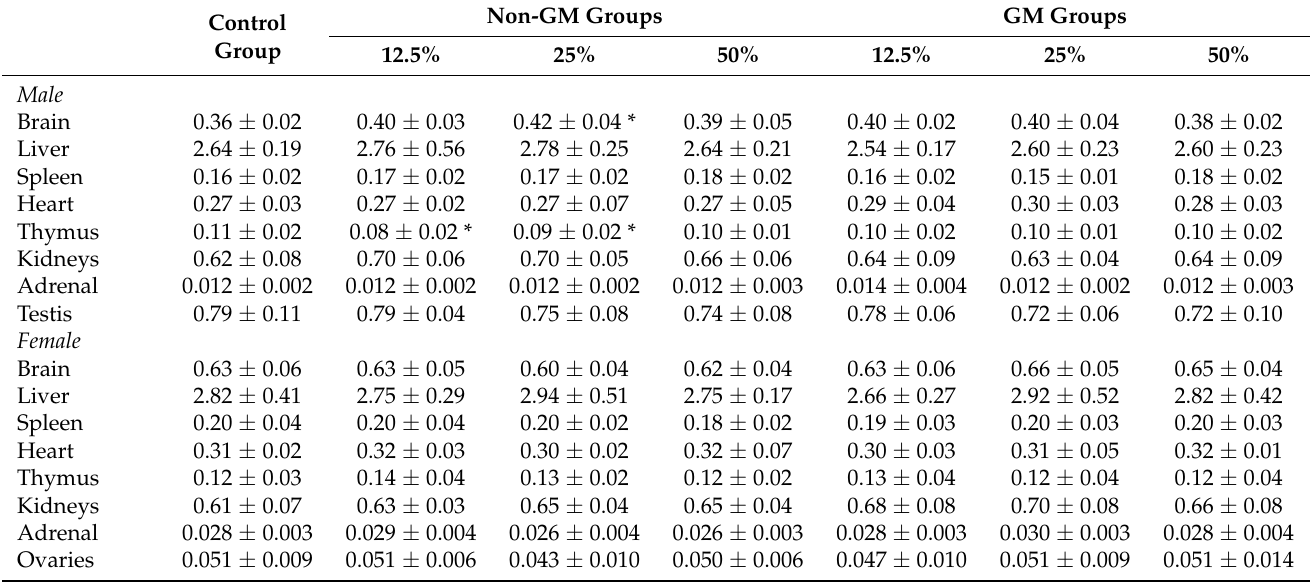
Table 9. Organ weight of male and female rats fed with different diets ( n =